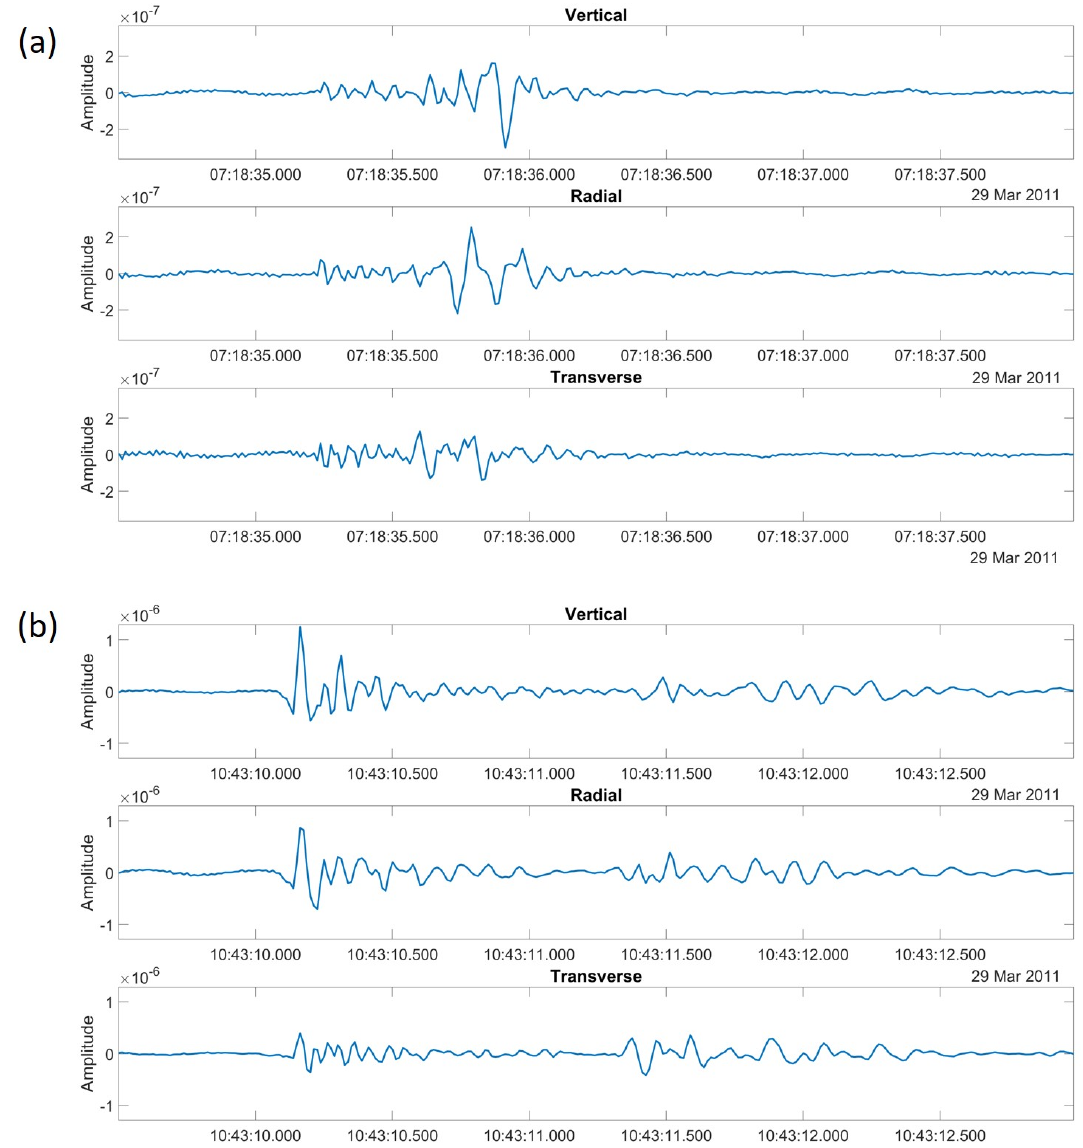
Figure C2. Three-component seismograms from SPITS station SPA0 for (a) an example of an event class I (frost quake) and (b) an example of an event class II (Gruve 7 mining activity). The signals are bandpass-filtered to 2.5–35Hz, and the horizontal components of ground motion (measured in north–south and east–west orientations) were rotated to radial and transverse to the source bearings estimated by MFP (see Fig. 5e and